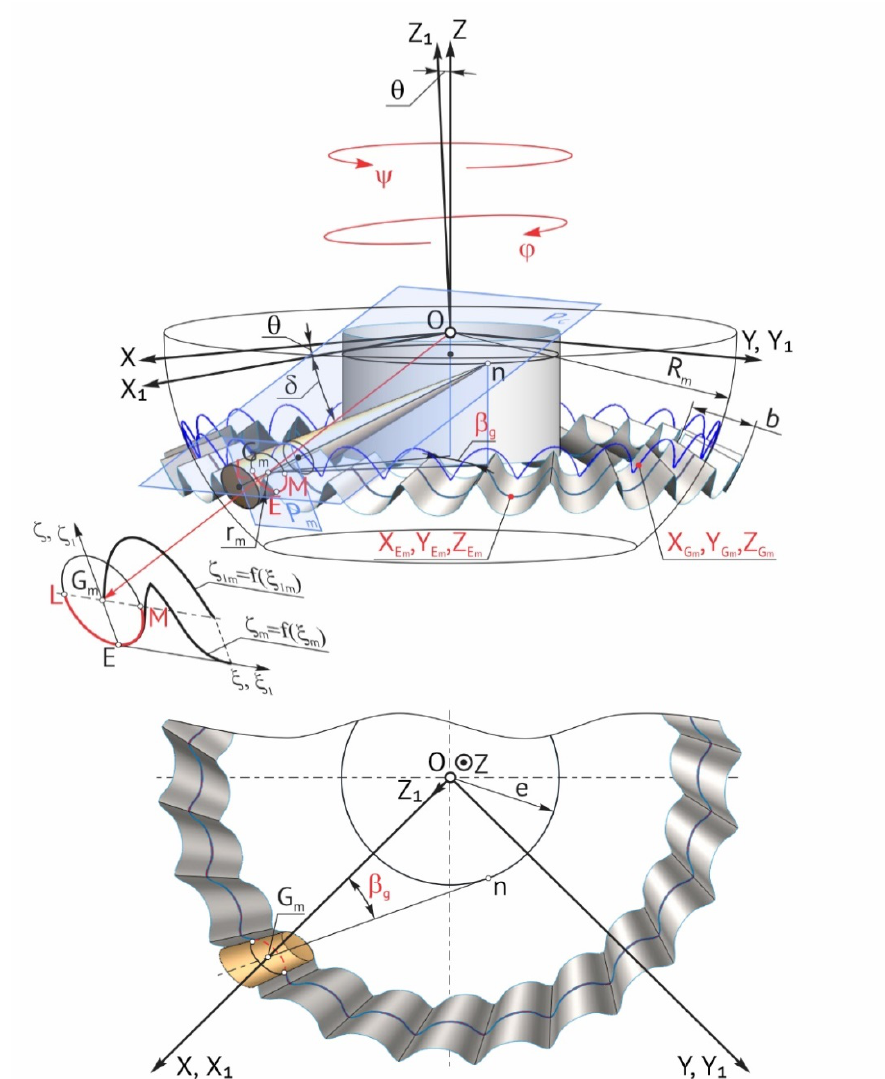
Figure 2. Description of the profile of the teeth in circle arc of the satellite wheel and covex-concave of the central wheel in the middle